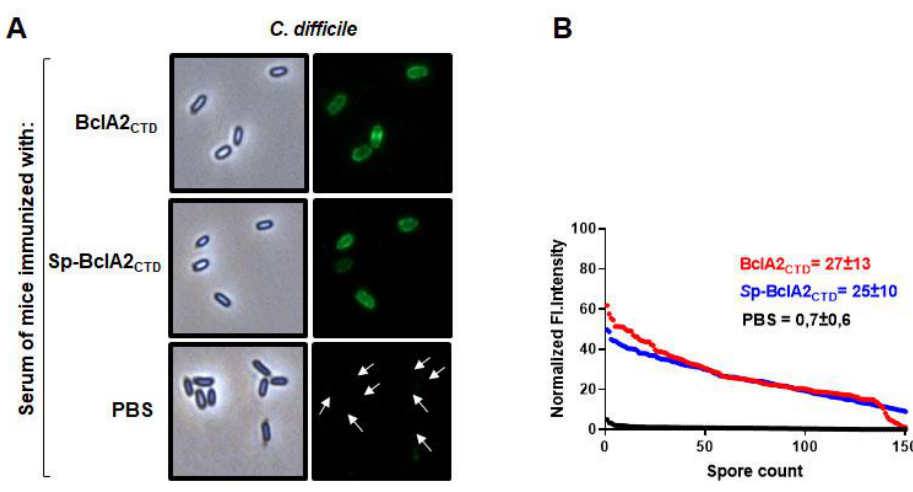
Figure 8. Recognition of C. difficile spores by the serum of animals immunized with purified BclA2 CTD and Sp-BclA2 CTD . ( A ) Spores of C. difficile R20291 were incubated 1 h with serum (1:100) of mice immunized with BclA2 CTD and Sp-BclA2 CTD or PBS, as indicated. ( B ) The immunofluorescence micrographs are depicted in fluorescence intensity (FI.Intensity) profiles provided by fluorescence microscopy images using ImageJ. The values shown in the graphs are the average ± standard error of the fluorescence intensity from 150 spores. The secondary antibody is anti-mouse conjugated with Alexa 488.